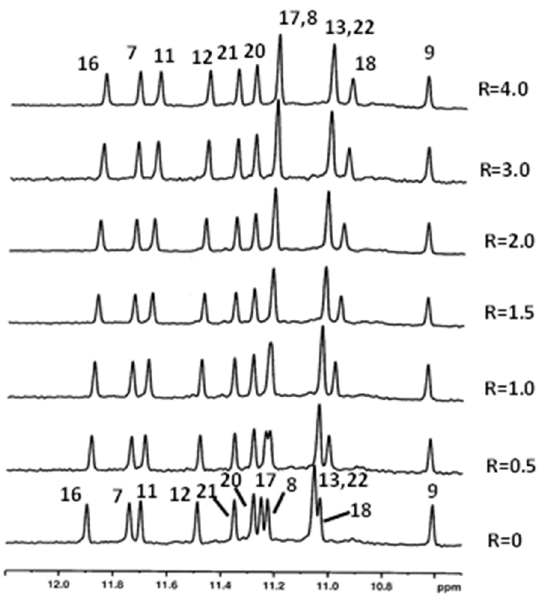
Figure 7. Imino protons region of the 1 H NMR titration spectra of Pu22T14T23 with aloin 3 at different R = [aloin]/[Pu22T14T23] ratios.